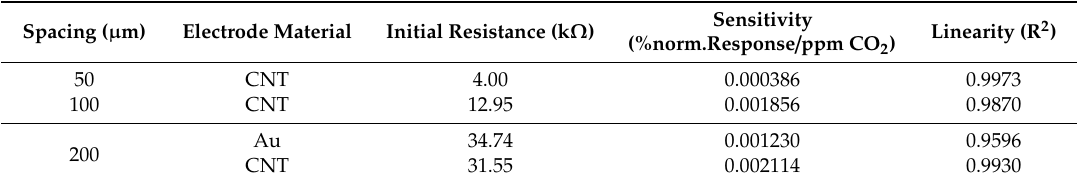
Figure 5. ( a ) Time response of fully transparent sensor to CO 2 ; ( b ) calibration curves of fully transparent sensorforCO 2 ; ( c )calibrationcurvestowardscarbondioxidefor200 µ mspacingforAuandCNTelectrodes. Table 2. Sensitivity towards CO 2